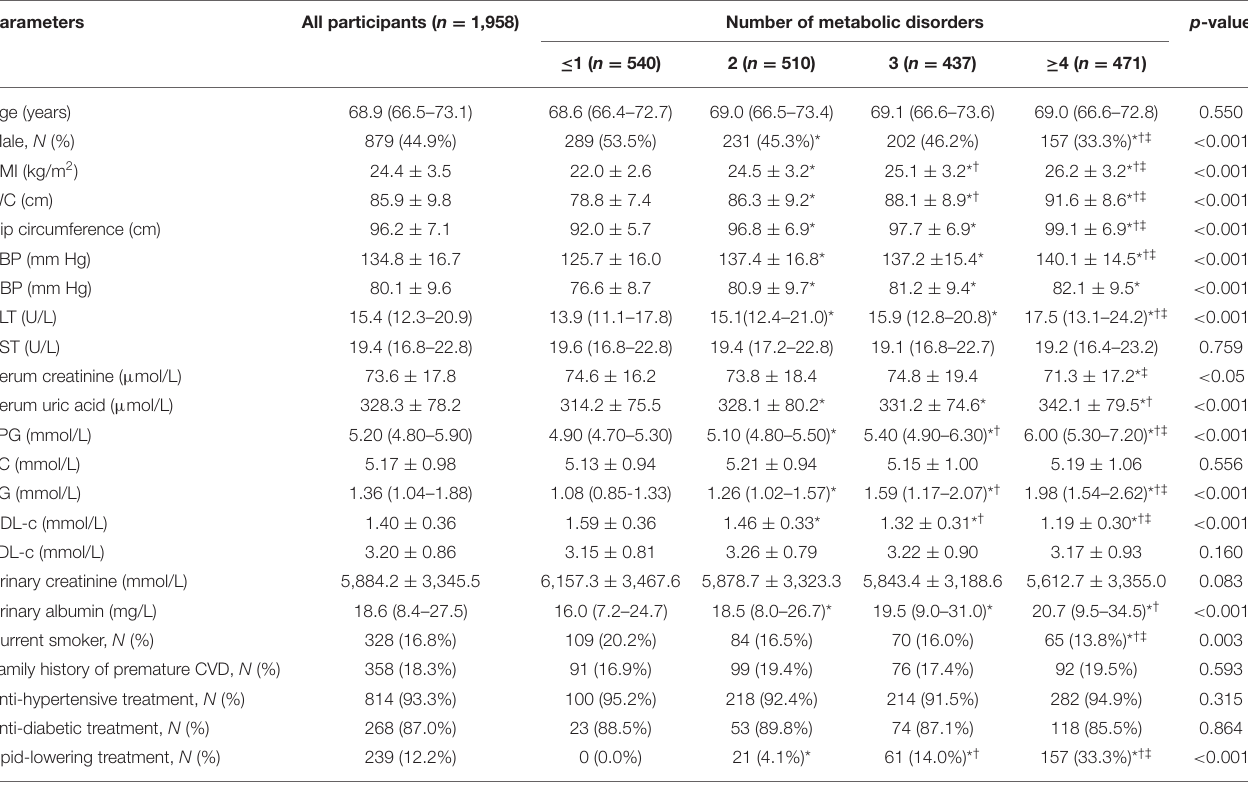
TABLE 1 | Characteristics of the participants according to the number of metabolic disorders.